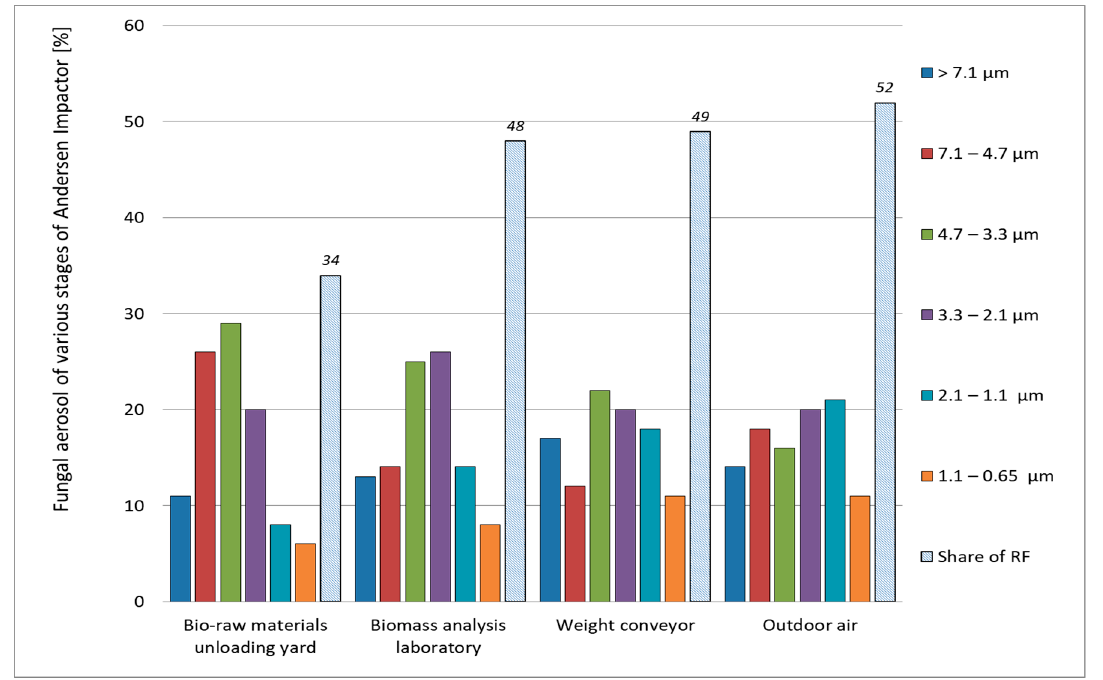
Figure 5 . Particle size distribution (PSD) of fungal aerosol in the analysed power plant. Figure 5. Particle size distribution (PSD) of fungal aerosol in the analysed power